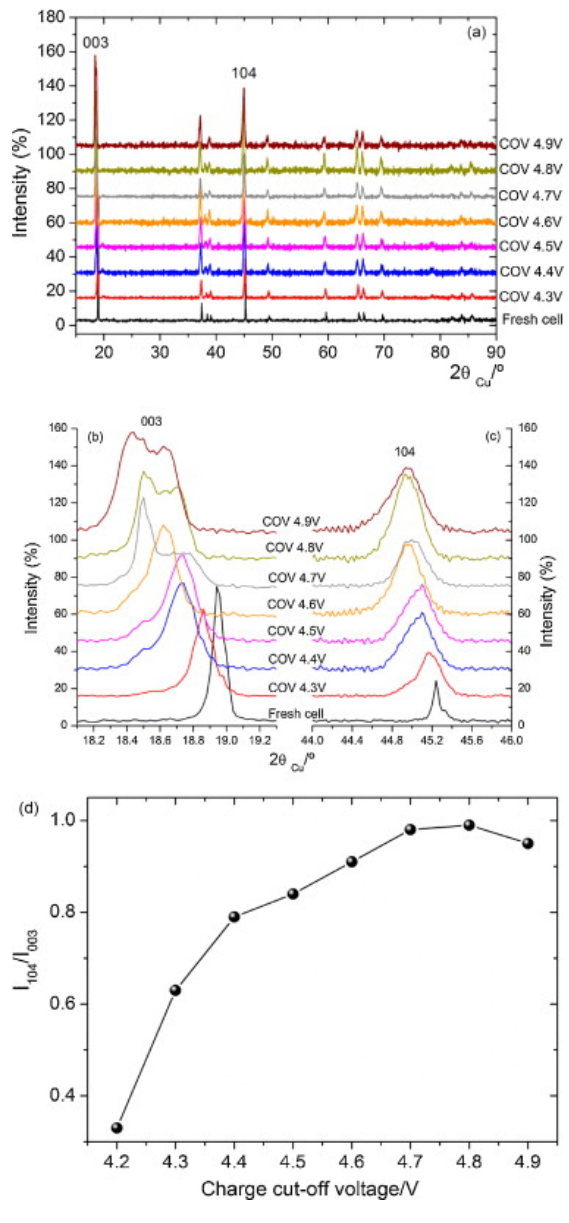
Figure 17. XRD patterns of LiCoO 2 before and after overcharge: ( a ) full pattern, ( b ) in the (003); ( c ) (104) peak area; ( d ) COV dependence of peak strength ration of I 104/003 [79]. Reprint with permission [79]; Copyright 2013, Elsevier.